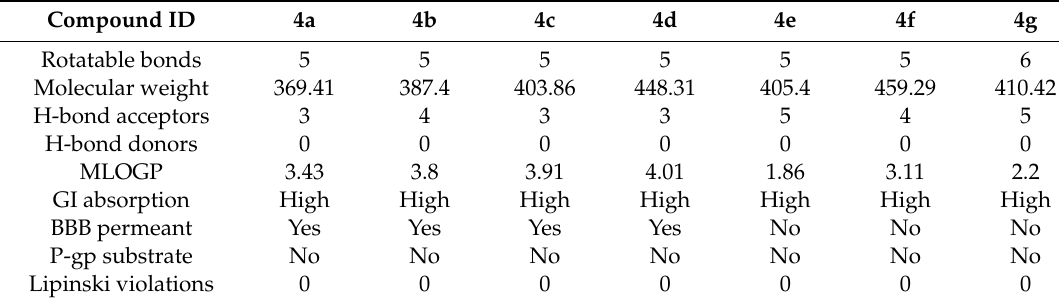
Table 5. The predicted pharmacokinetic properties of all the synthesized compounds.